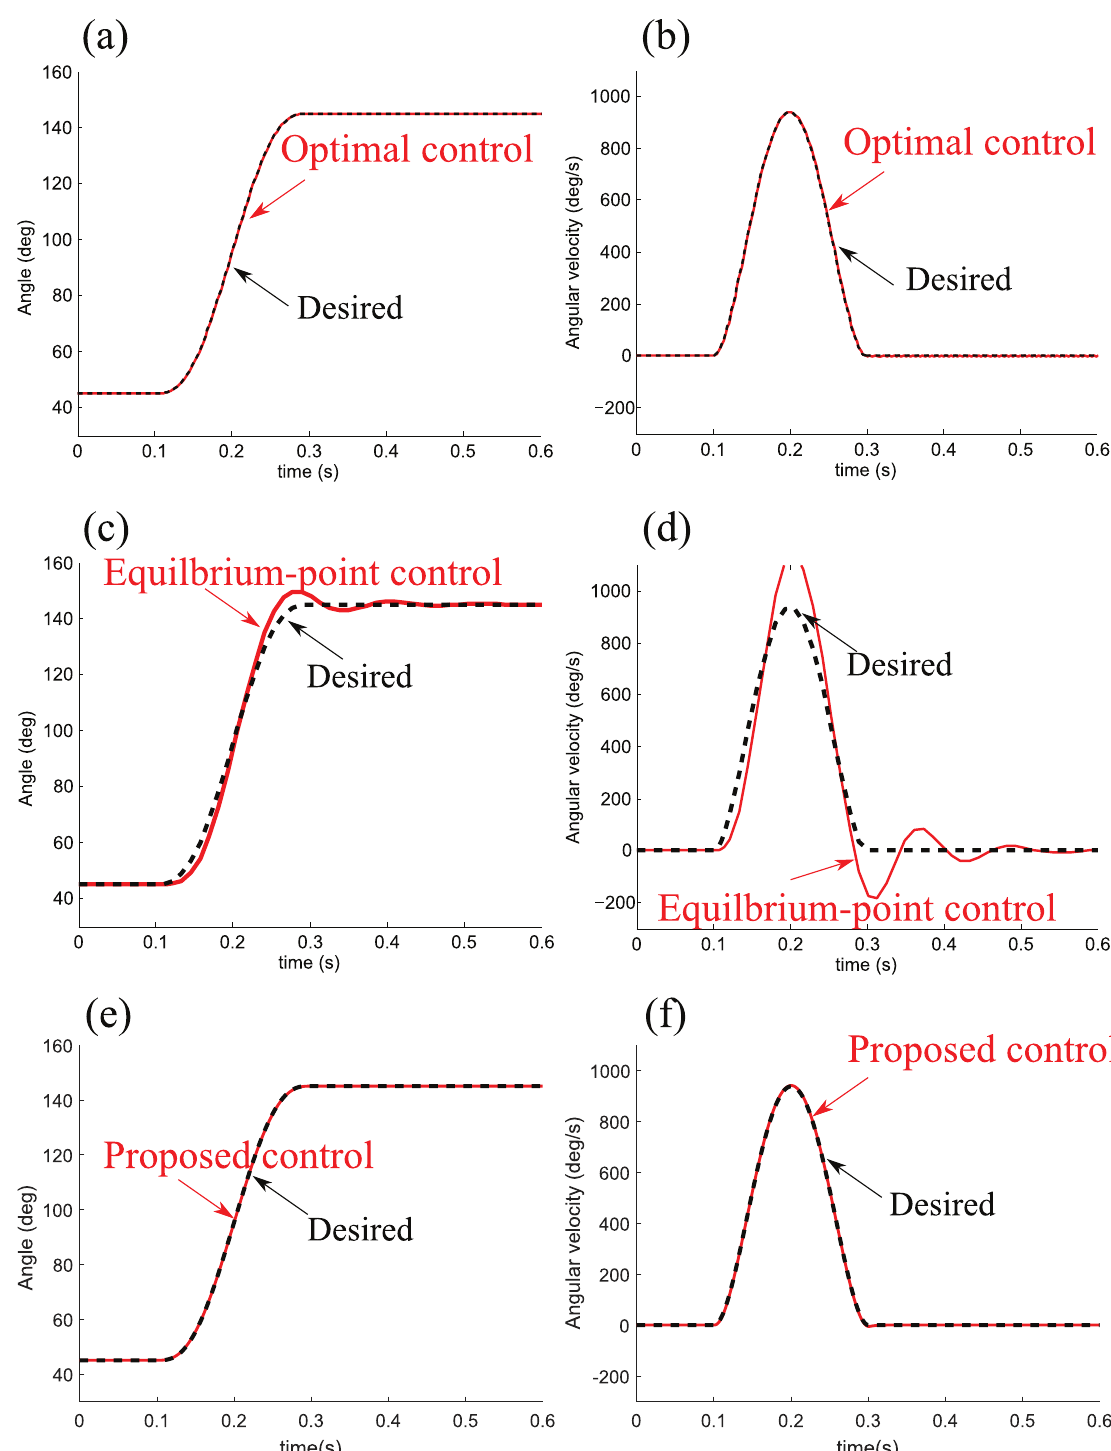
Fig 6. Simulated fast movement with a delay of 65 ms. A single-joint fast movement are reproduced by the optimal control, equilibrium- point control and proposed control. The optimal control (a, b) and proposed control (e, f) reproduce the minimum-jerk trajectory, while the equilibrium-point control (c, d) fails to reproduce the minimum-jerk movement within the range between the 0.1 s and 0.3 s.